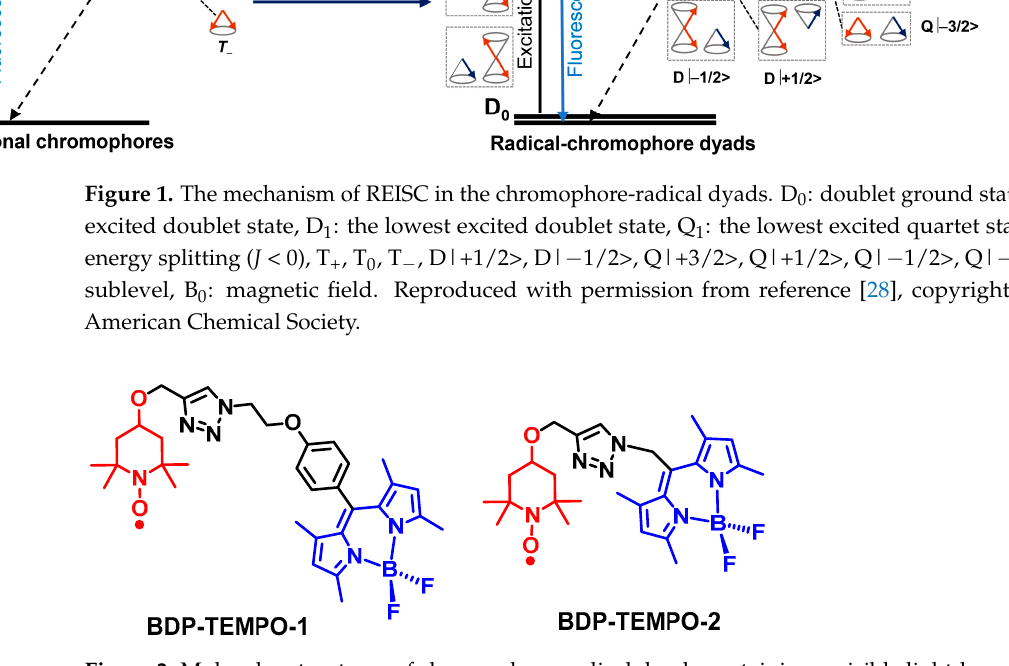
Figure 2. Molecular structures of chromophore-radical dyads containing a visible light-harvesting chromophore and a stable radical, BDP-TEMPO-1 and BDP-TEMPO-2.